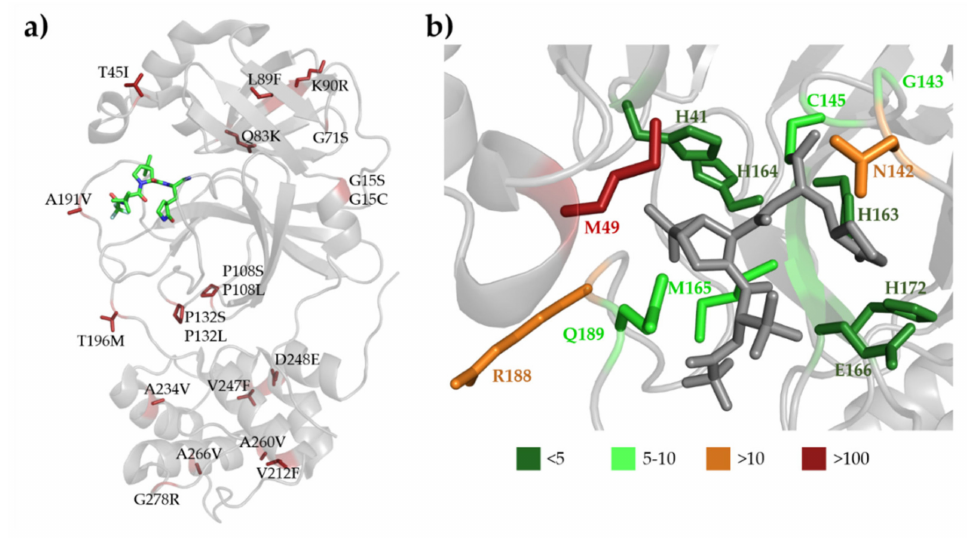
Figure 5. SARS-CoV-2 Mpro sequence variations at the active site. ( a ) The 20 most frequently occurring mutations (based on Figure 3) are shown by red sticks in the crystal structure of the enzyme (7RFS.pdb); the nirmatrelvir bound to the active site is also shown by sticks. ( b ) Enlarged view of the active site showing the inhibitor (gray) and the residues involved in nirmatrelvir binding. The residues are colored according to the number of the known variations in the given